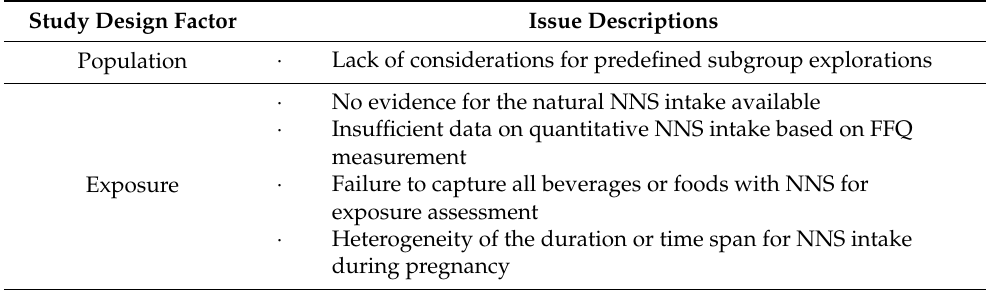
Figure 3. Dose-response relationship between NNS intake during pregnancy and WMD in BMI z-score (( a ) for different NNS level in relation to WMD at 1 year of age; ( b ) for increased offspring’s ages in relation to WMD). Table 3. Some methodological issues identified from the included human